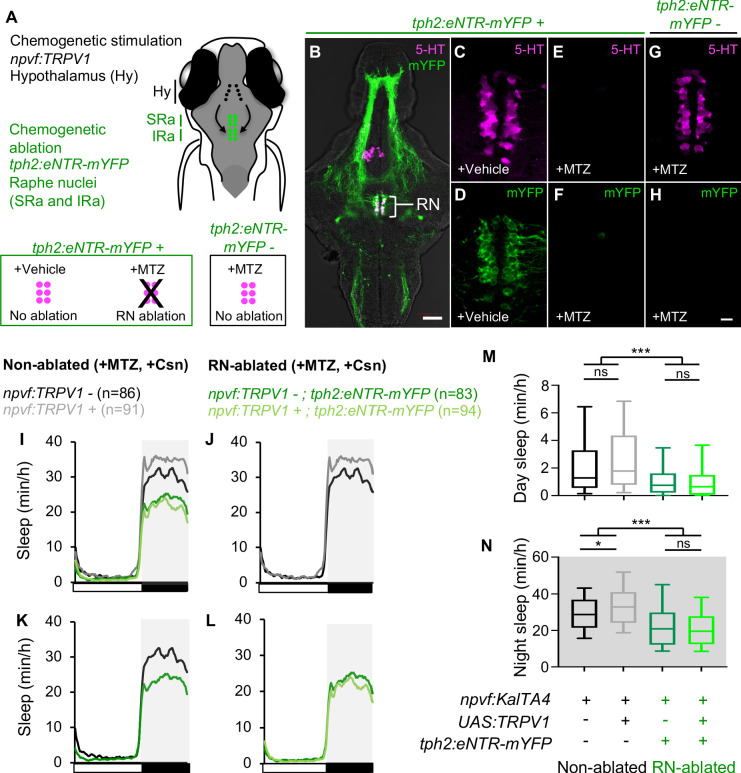
Chemogenetic ablation of the RN abolishes sleep induced by chemogenetic stimulation of NPVF neurons.(A) Schematic of experiment. Animals were first treated with MTZ to ablate serotonergic RN neurons in Tg(tph2:eNTR-mYFP) animals but not in non-transgenic sibling controls. Behavior was then monitored during chemogenetic stimulation of npvf-expressing neurons in Tg(npvf:KalTA4); Tg(UAS:TRPV1-TagRFP-T) animals in parallel with their non-stimulated Tg(npvf:KalTA4) sibling controls. (B) 5-dpf Tg(tph2:eNTR-mYFP) zebrafish brain showing serotonergic RN neurons and some of their projections (green) and labeled with a 5-HT-specific antibody (magenta). The bracketed region is magnified in (C–H). Treatment of Tg(tph2:eNTR-mYFP) animals with MTZ results in the loss of both 5-HT immunoreactivity (E) and mYFP (F) in the RN, but treatment with DMSO vehicle control does not (C,D). MTZ treatment of Tg(tph2:eNTR-mYFP) negative siblings does not result in loss of RN neurons (G). Images are single 4-μm- (B) and 0.6-μm- (C–H) thick optical sections. Scale: 50 μm (B), 10 μm (C–H). (I–L) Sleep of 5-dpf Tg(npvf:KalTA4) (black), Tg(npvf:KalTA4); Tg(UAS:TRPV1-TagRFP-T) (gray), Tg(npvf:KalTA4); Tg(tph2:eNTR-mYFP) (dark green), and Tg(npvf:KalTA4); Tg(UAS:TRPV1-TagRFP-T); Tg(tph2:eNTR-mYFP) (light green) siblings treated with 2 μM Csn. White and black bars under behavioral traces indicate day and night, respectively. (M,N) Box plots quantify sleep during day (M) and night (N). n = number of animals. ns p>0.05, *p<0.05, ***p<0.005, Two-way ANOVA with Holm-Sidak test.